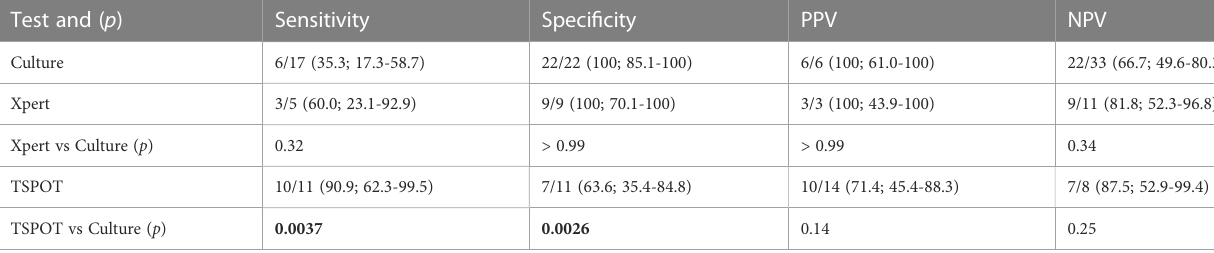
TABLE 3 The diagnostic accuracy of culture, smear, Xpert, PCR, and TSPOT in non-biopsy samples. Test and ( p